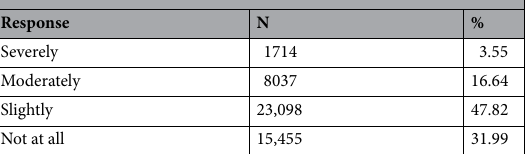
Q. How much do these noises worry, annoy or upset you when they are at their